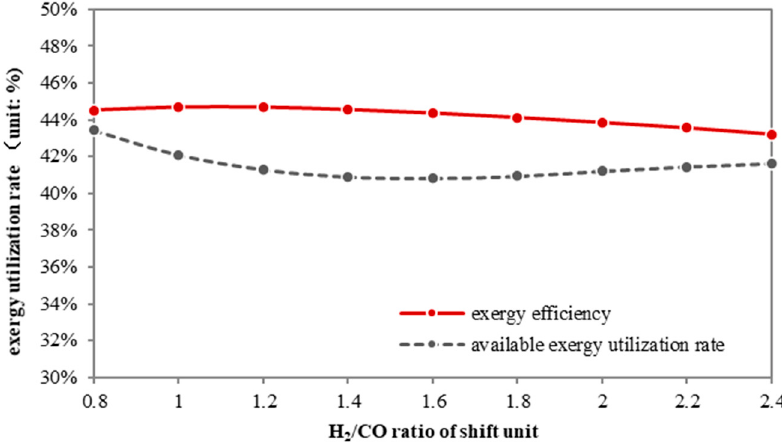
Figure 8. Exergy efficiency and physical exergy efficiency of polygeneration w/partial shift. Table 5. Comparison of exergy loss in two once-through series cases (unit: % of total exergy